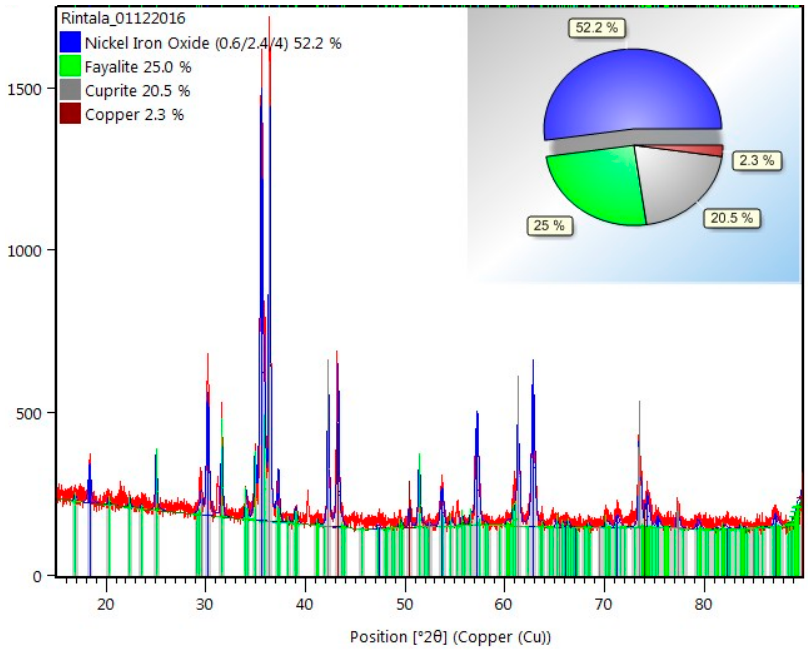
Figure 2. The obtained X-ray diffraction (XRD) pattern of the raw material. Table 2. SEM-EDS point analysis of the particles presented in Figure 3.